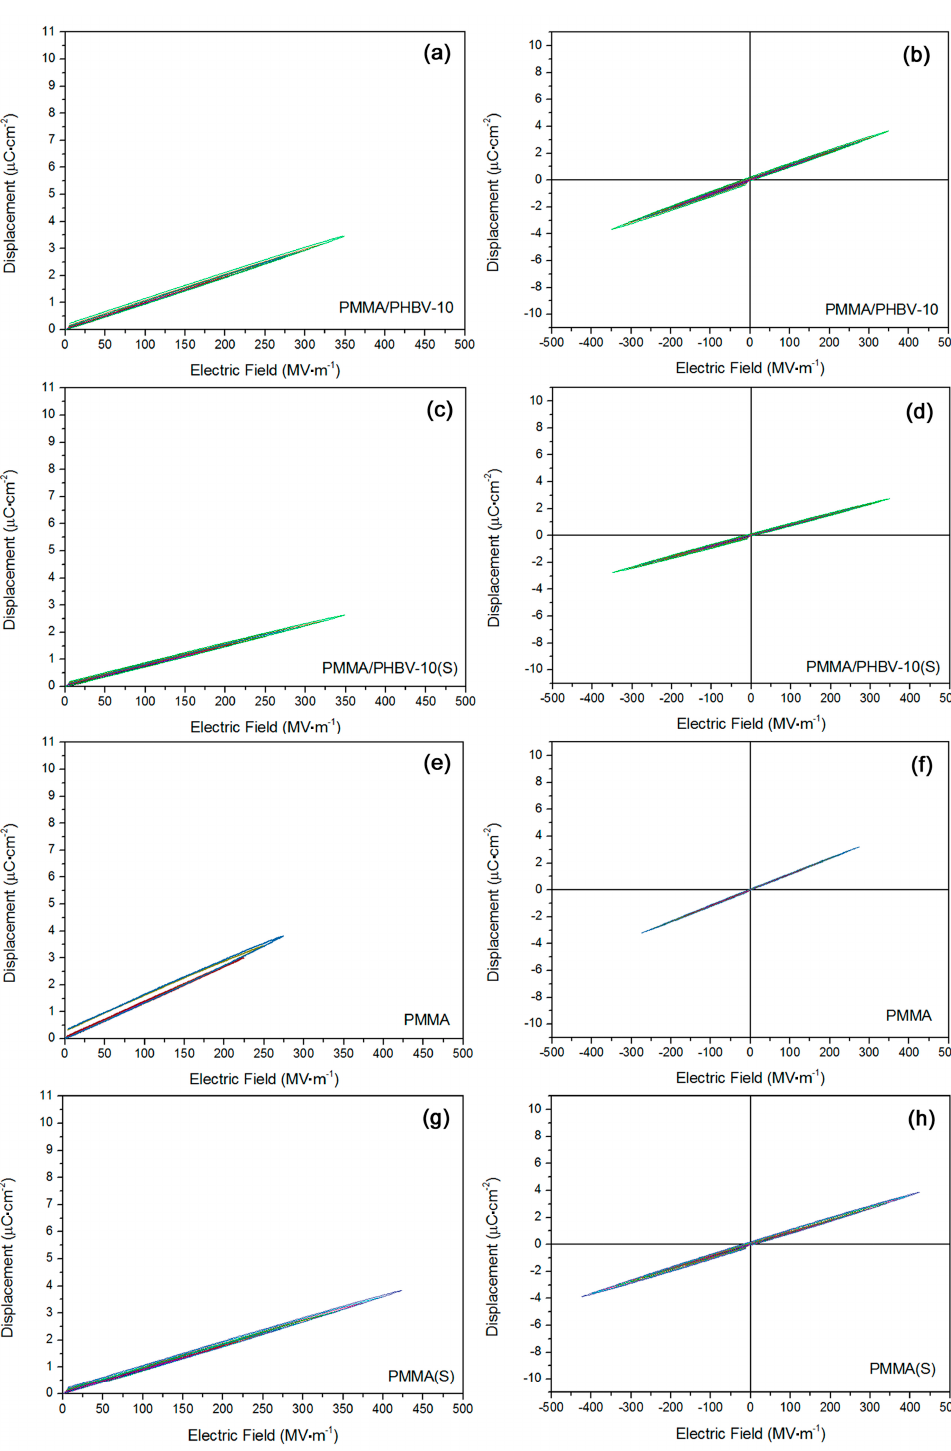
Figure 5. Fine linear dielectric nature was confirmed based on D - E loops results for ( a , b ) PMMA/PHBV-10 sample; ( c , d ) stretched PMMA/PHBV-10 sample, ( e , f ) neat PMMA sample; and ( g , h ) stretched PMMA sample.